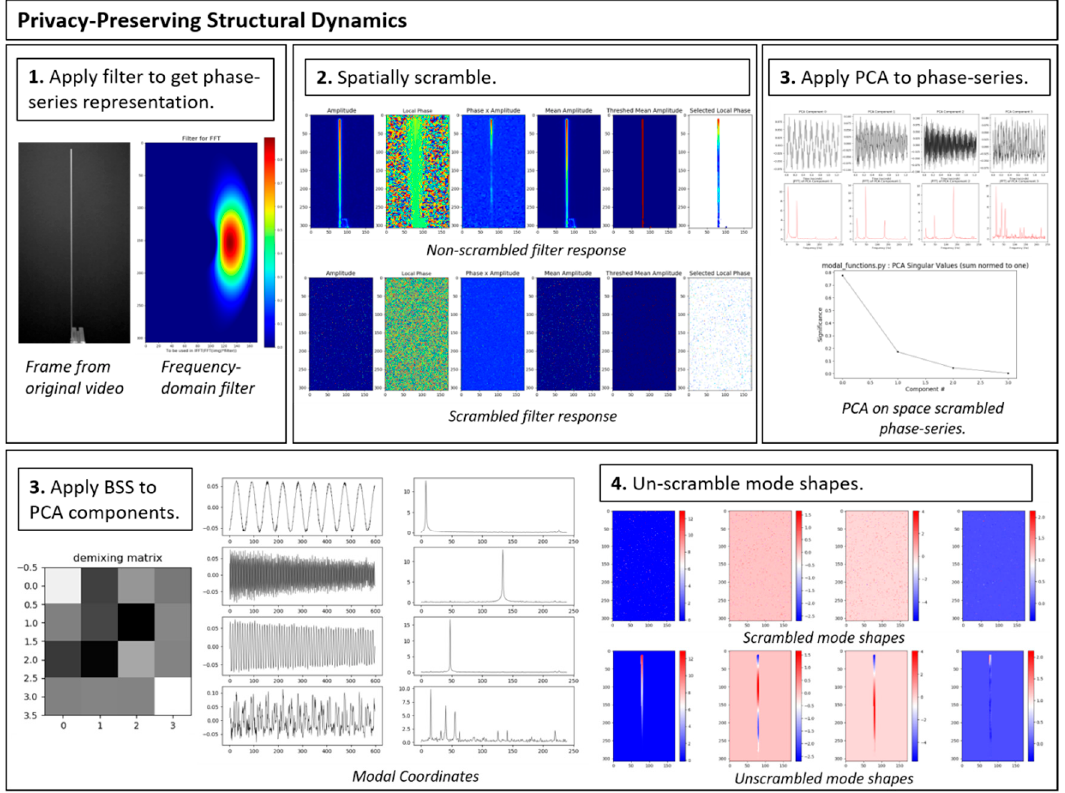
Figure 26. Demonstration of privacy-preserving structural dynamics identification.